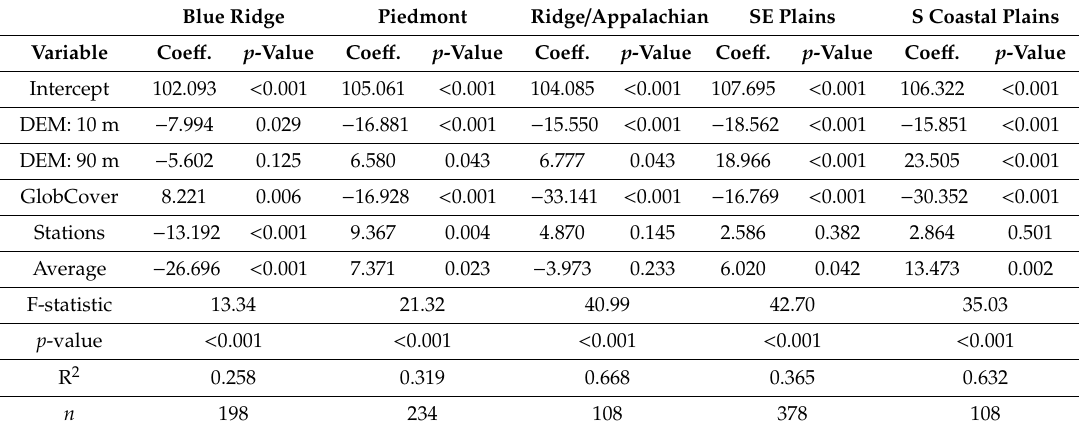
Table 5. Outputs of the multivariate linear regression models predicting the percentage change in nitrogen export (kg / ha / year) with respect to the Baseline Scenario for the five physiographical regions of Georgia using input spatial data as independent variables (digital elevation model (DEM), land cover and